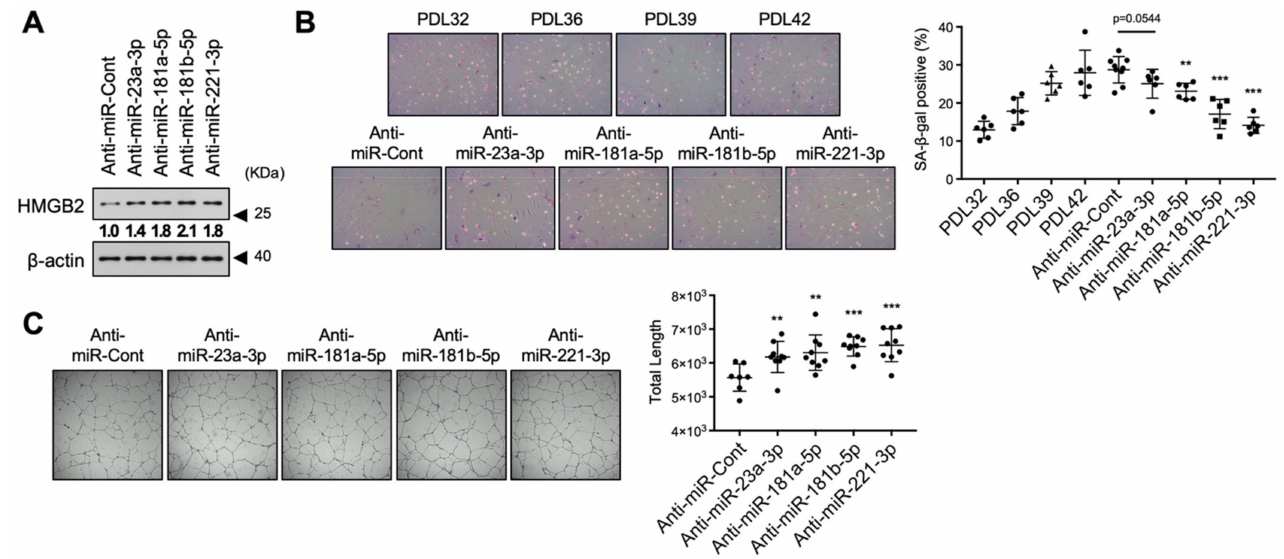
Figure 6. Treatment with miRNA inhibitors delayed cellular senescence in MVECs. ( A ) MVECs (PDL42) were transfected with miRNA inhibitors, and HMGB2 protein levels were determined via immunoblot analysis. Numbers in bold indicates the relative amount of HMGB2 normalized with β -actin. ( B ) Senescence in MVECs was determined via SA- β -gal staining and the proportion of SA- β -gal-positive cells was compared statistically. ( C ) The effect of miRNA mimics on the angiogenic activity of MVECs was analyzed via in vitro tube formation assays, and the total length of tube-like structures in a field was statistically compared. ** p < 0.01. *** p <